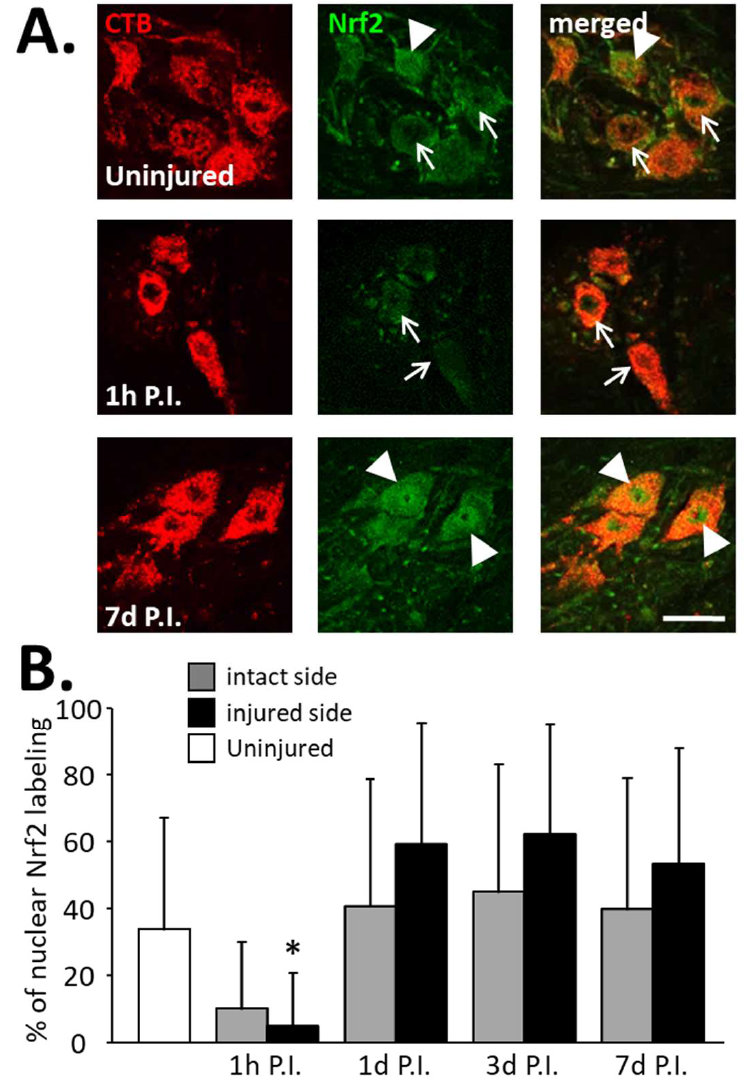
Figure 6. Percentage of phrenic motoneurons expressing nuclear Nrf2 following C2 hemi-section. ( A ) Representative images showing the expression of Nrf2 in phrenic motoneurons labeled with CTB in uninjured animals and in denervated phrenic motoneurons in C2 hemisected rats, 1 h and 7 d post-injury (P.I.). White arrowheads show phrenic motoneurons without nuclear Nrf2 expression. White arrows show phrenic motoneurons with nuclear Nrf2 expression. ( B ) Percentage of phrenic motoneurons expressing nuclear Nrf2 for uninjured animals, and intact and injured sides of C2 hemisected animals 1 h, 1 d, 3 d, and 7 d following injury. * Compared to 1 h P.I., 3 d P.I., and 7 d P.I. corresponding sides, p <